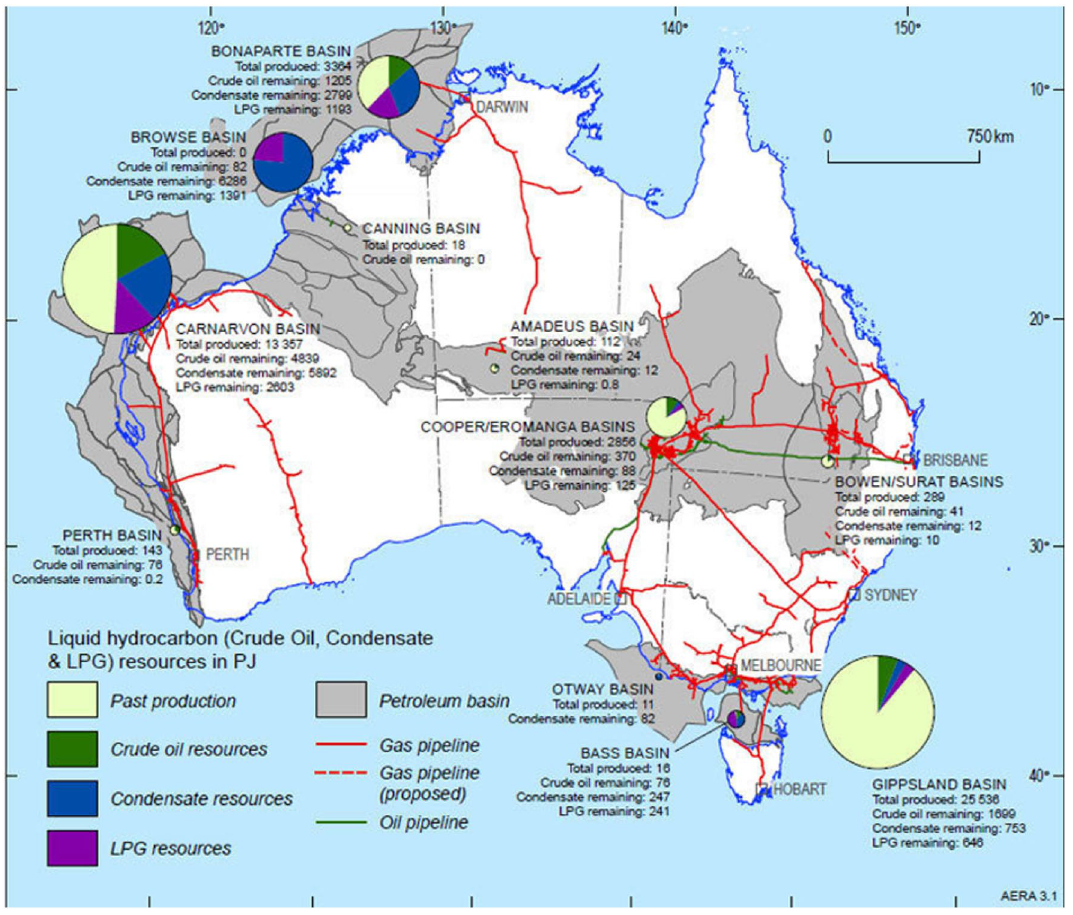
Fig. 3 Past production, crude oil, LPG and condensate resources, and other resources of Australian crude oil (GeoScience, 2018. http://www. ga.gov.au/scien tific -topic s/energ y/resou rces/petro leum-resou rces/oil)